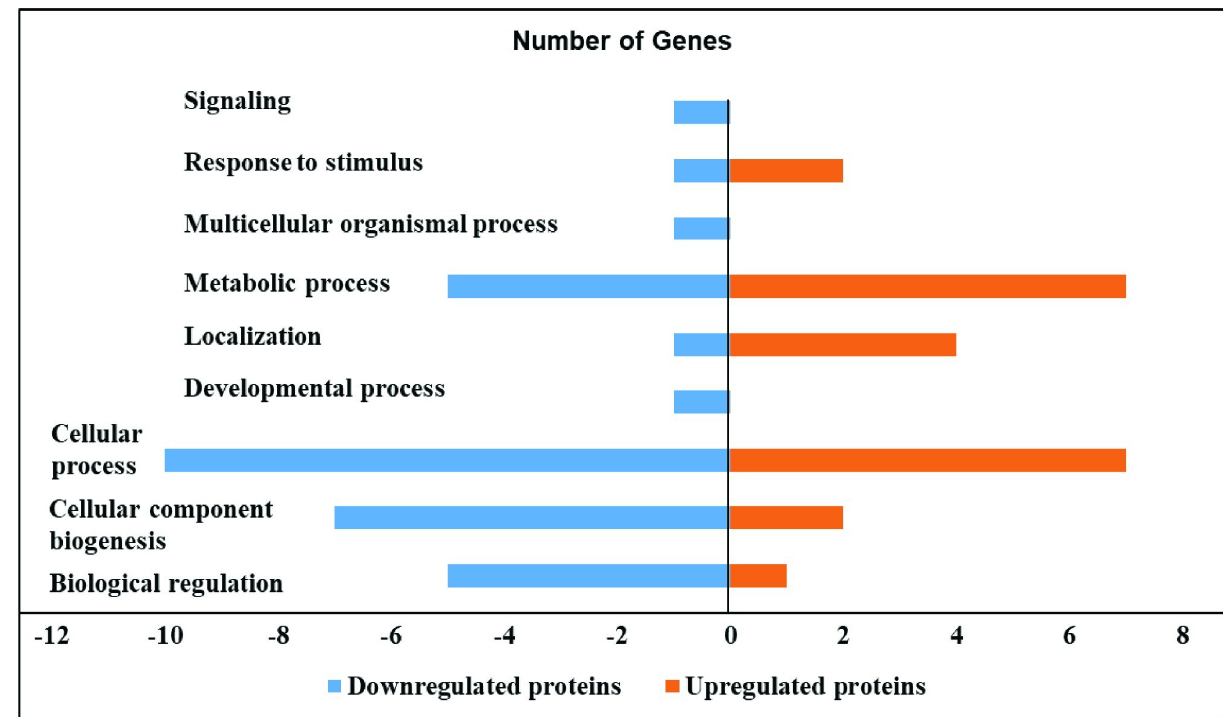
Fig 1. Effect of S . Enteritidis on the proteome of HTC cells. S . Enteritidis infection in HTC cells induced down and upregulated proteins in different biological processes. HTC cells were treated with S . Enteritidis for 4 h, proteins were extracted and analyzed by tandem mass spectrometry. Differentially expressed proteins were calculated using Scaffold software ( P < 0.05) and biological processes were predicted by using STRING and PANTHER software.